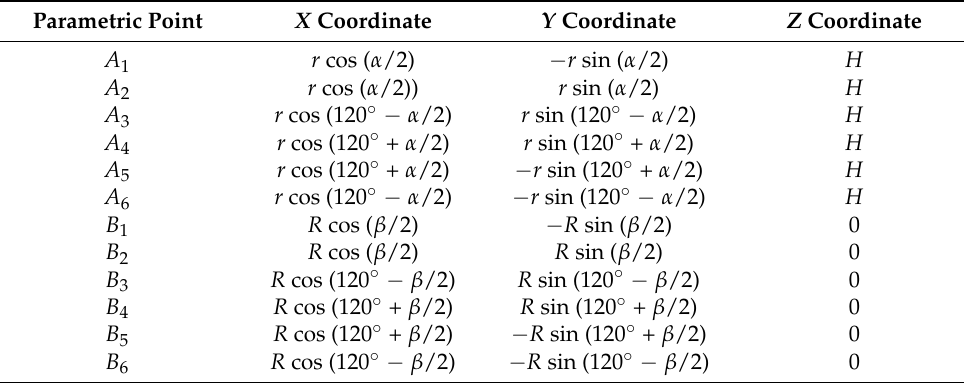
Table 1. Parameterized point coordinates of the 6-UPS parallel mechanism.